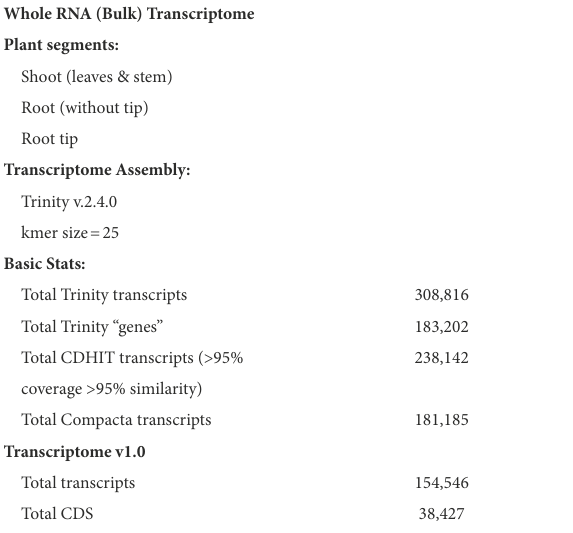
TABLE 1 Basic information of the de novo Ceratopteris richardii transcriptome from young sporophyte segments. Ceratopteris richardii Hn-n Whole RNA (Bulk)